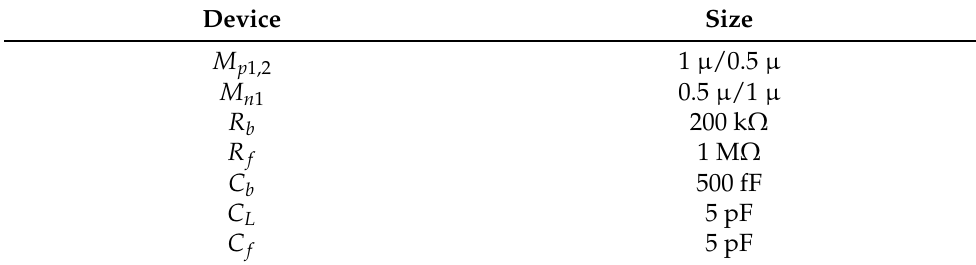
Table 1. Device dmension of envelope detector.